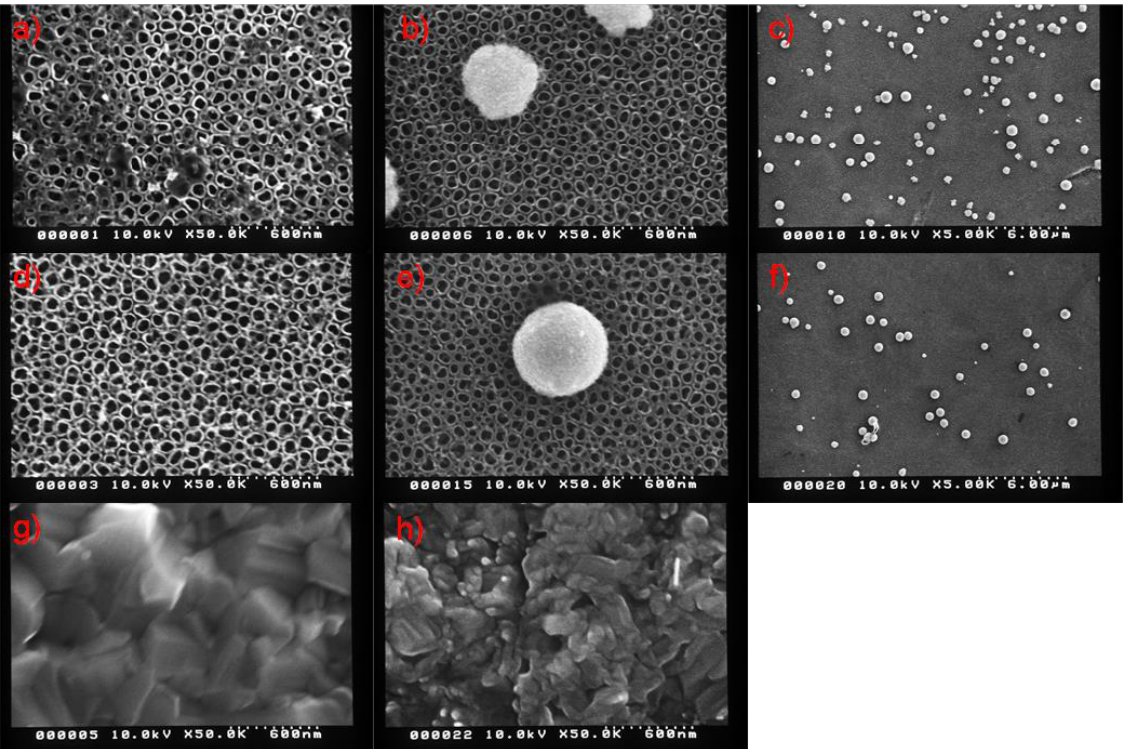
Figure 1. SEM images of TNTs. Calcination temperature: 300 °C for ( a – c ), 500 °C for ( d – f ), and 700 °C for ( g , h ). ( a , d , g ) before irradiation. ( b , c , e , f , h ) after irradiation.